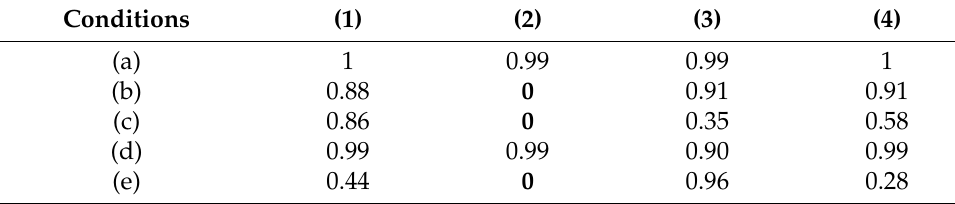
Table 3. Statistical test: Inter-packet length ( p